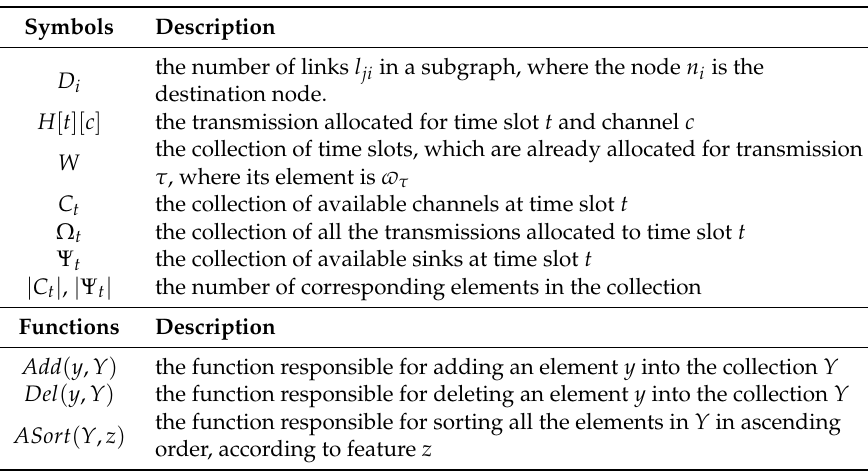
Table 1. Symbols and